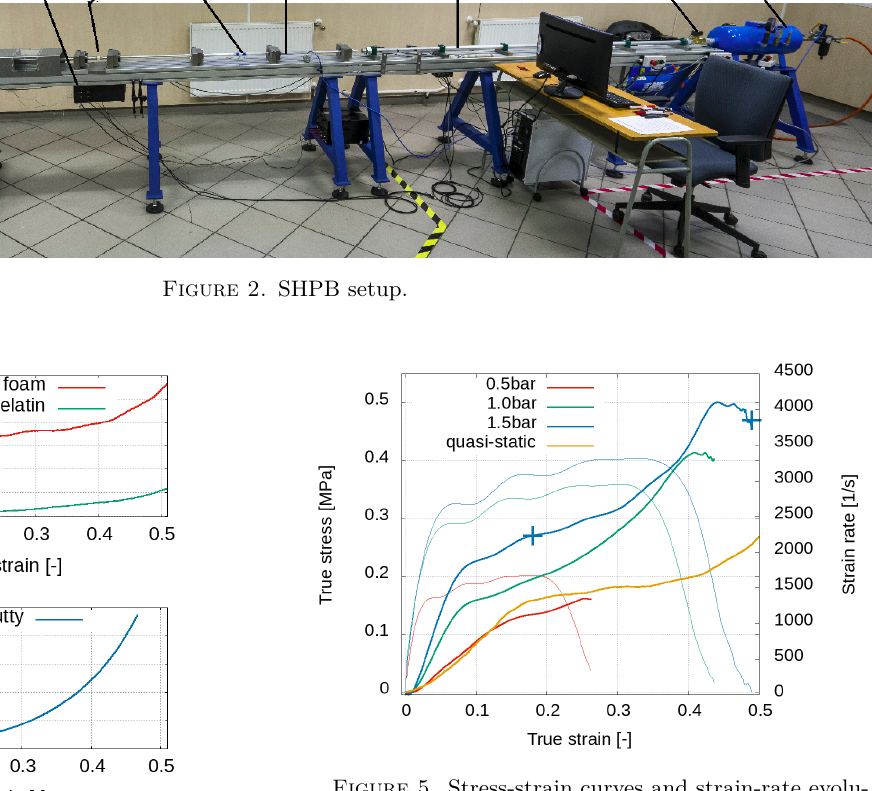
Figure 5. Stress-strain curves and strain-rate evolu- tion for group of polyurethane foam specimens.